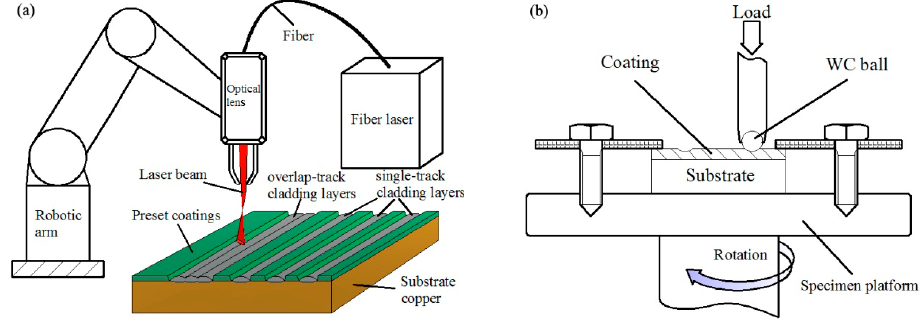
Figure 2. The schematic diagram of ( a ) the fiber laser material processing system ( b ) the wear test system.